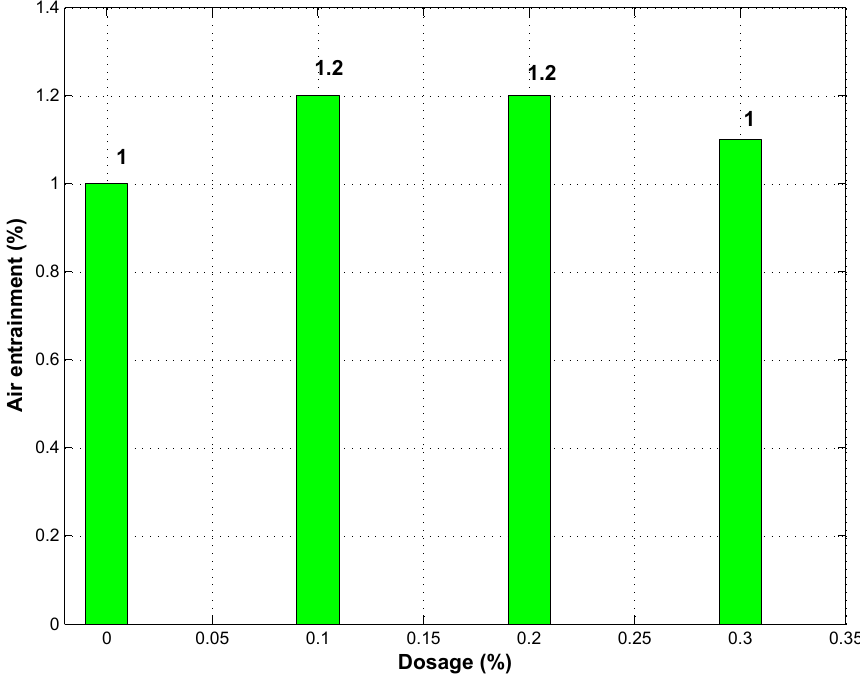
Figure 5. Percentage of air entrainment of concrete samples with